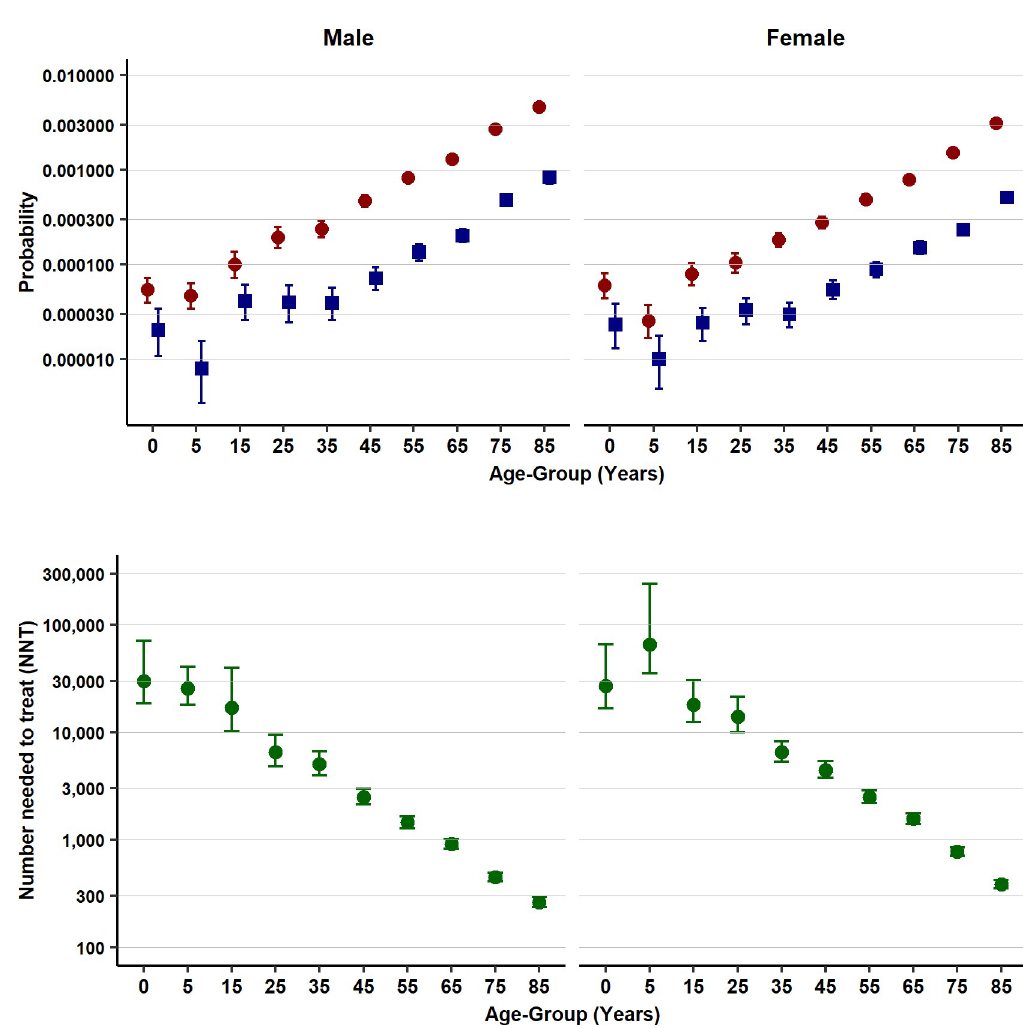
Fig 2. Probability of sepsis following infection consultations in primary care if ABs are prescribed or not (upper panel). Number of antibiotic prescriptions required to prevent one sepsis event (NNT) (lower panel). Figures are median probabilities (95% uncertainty interval). AB, antibiotic; NNT, number needed to